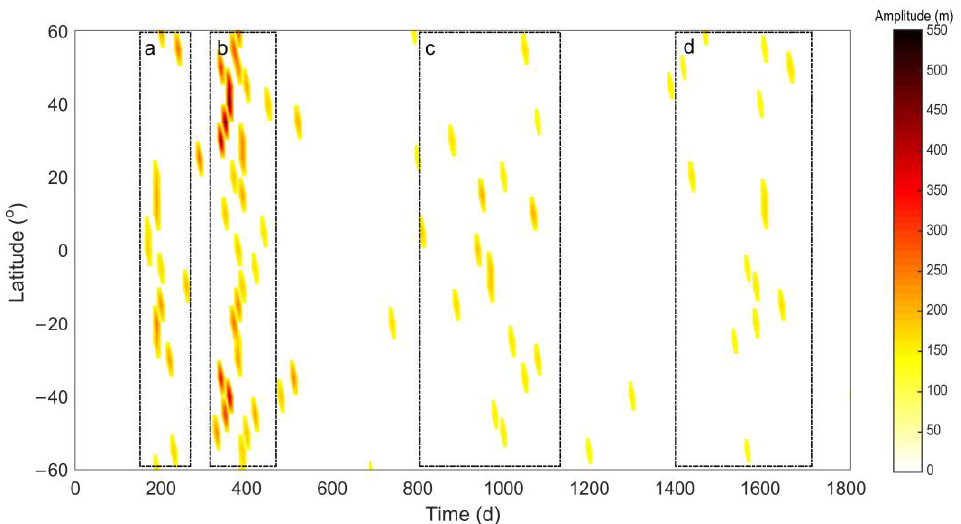
Figure 7. The result of HHT of altitude variation of 70° S–70° N from 2007 to